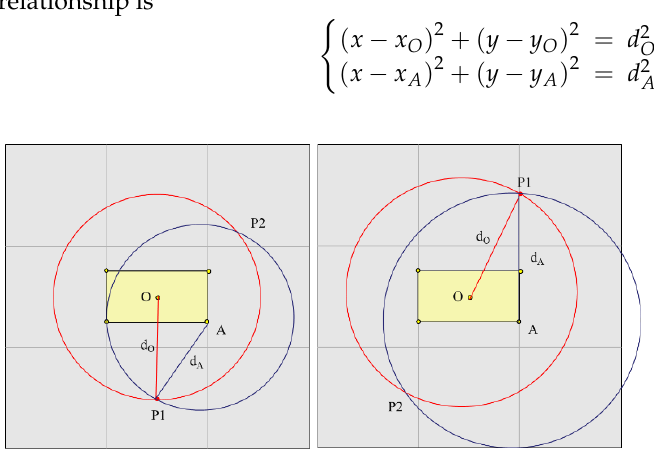
Figure 10. Schematic diagram of the pseudo-twin light positioning algorithm.